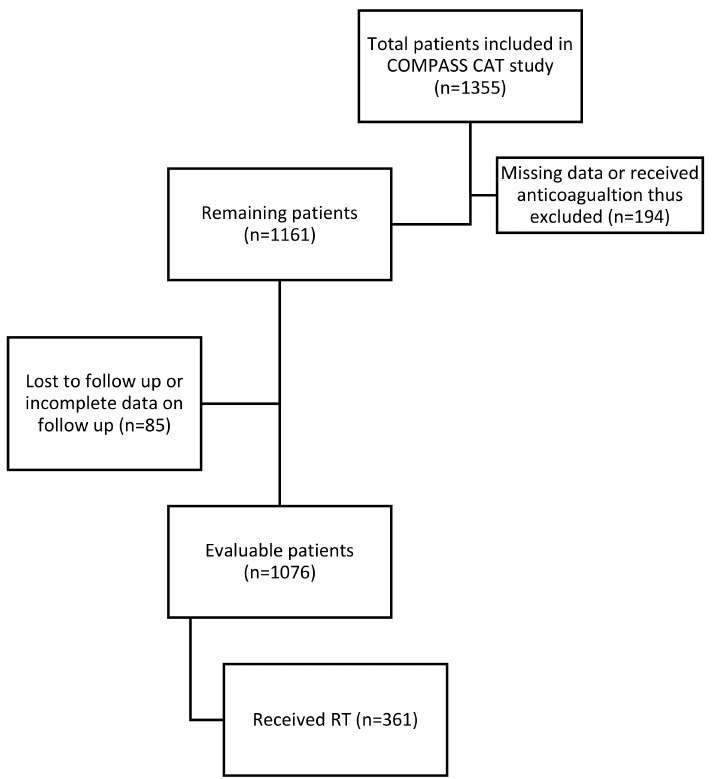
Figure 1. Flow chart of patients from COMPASS-CAT study included in the competing-risks regres- sion model. Table 1. Baseline characteristics for evaluable patients and those who received radiotherapy